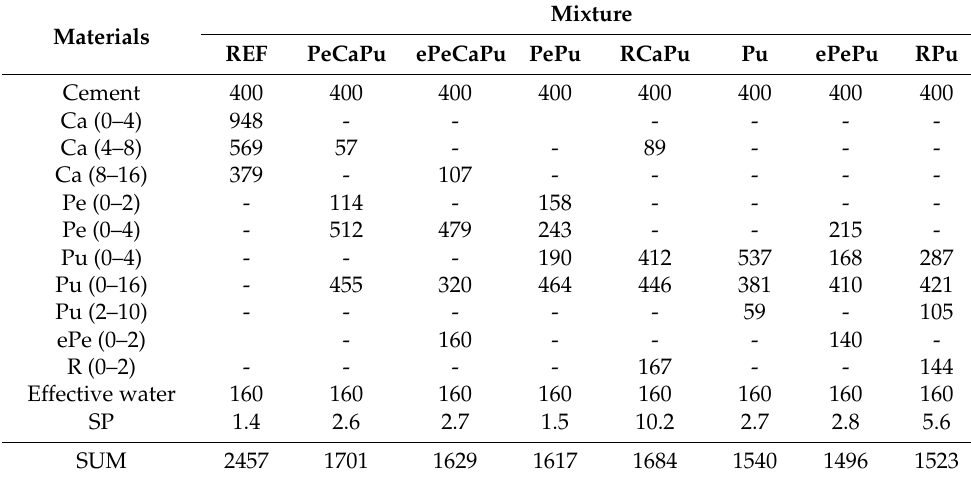
Figure 1. Grading curves of all aggregates used in the different concrete mixtures. Table 3. Concrete mixtures proportions (kg/m 3